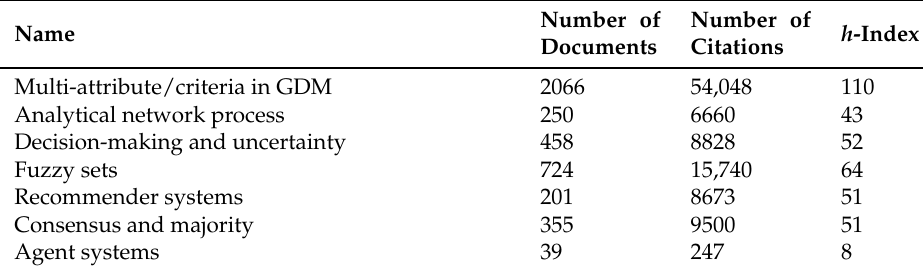
Table 7. Performance of thematic